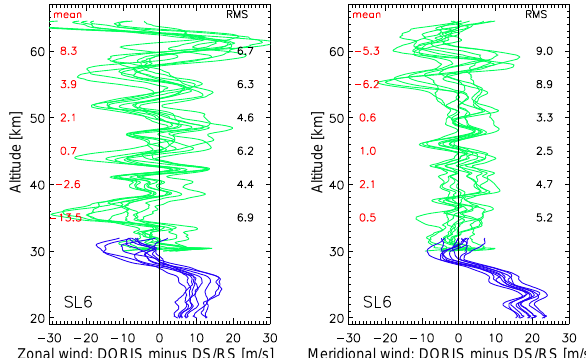
Figure 12. Green lines: differences between DoRIS profiles within a time period of ± 20min of a particular datasonde flight, shown for all datasonde flights. Blue lines: differences of all DoRIS profiles to the mean radiosonde profile shown in Fig. 7. Red lines: mean of the differences. Black lines: root-mean-square variability of the differences relative to the mean difference. See text for more details. Left: zonal winds, right: meridional